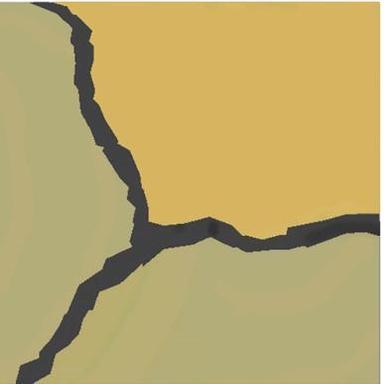
The schematic unexposed and exposed grain boundaries after long-term exposure. The M23C6 and γ́ created a continuous grain boundary.